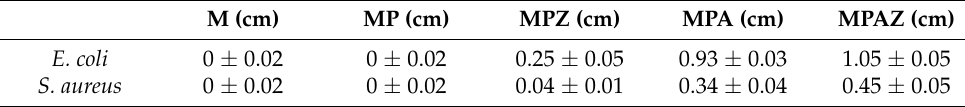
Table 1. The diameters of the bacteriostatic zones of different